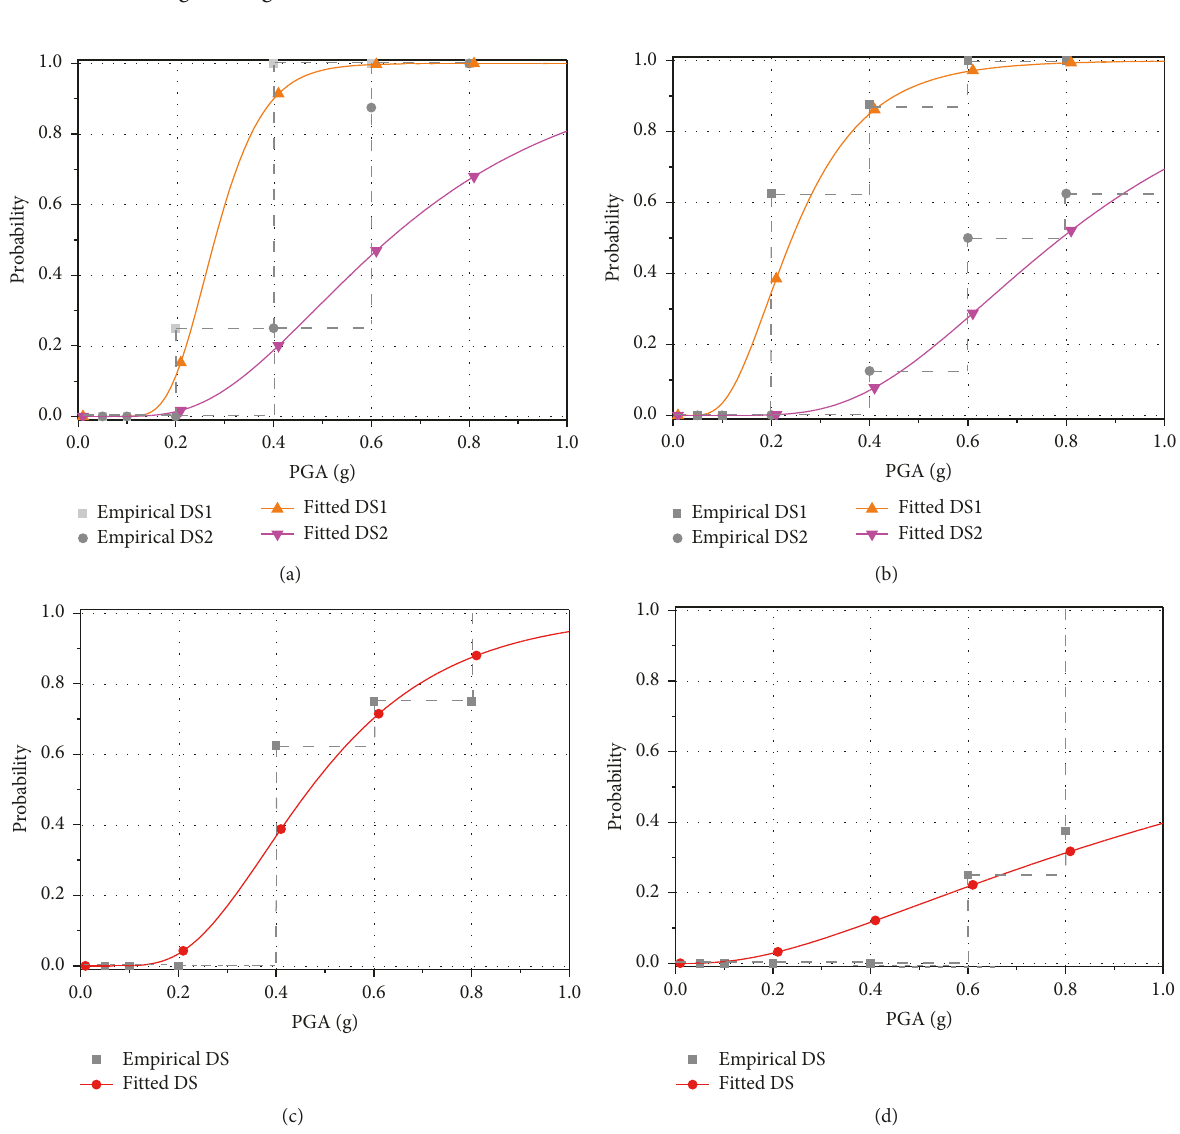
Figure 10: Generated fragility curves of four components: (a) pier acceleration; (b) pylon drift; (c) bearing displacement; and (d) deck